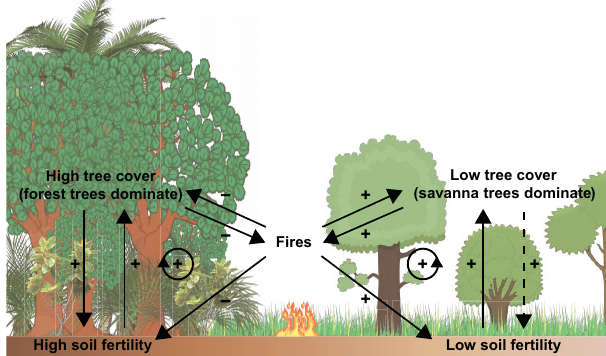
Figure 2. Relations between forest tree cover, savanna tree cover, fire and soil fertility. These relations create positive feedback loops that explain alternative stable states in tree cover. The dashed arrow is hypothetical, but note that the positive feedback loop does not de- pend on it. The model is based on previous studies (Jackson, 1968; Bond, 2010; Wood and Bowman, 2012; Dantas et al., 2013; Silva et al., 2013; Franco et al., 2014; Bowman et al., 2015; Gray and Bond, 2015; Paiva et al.,